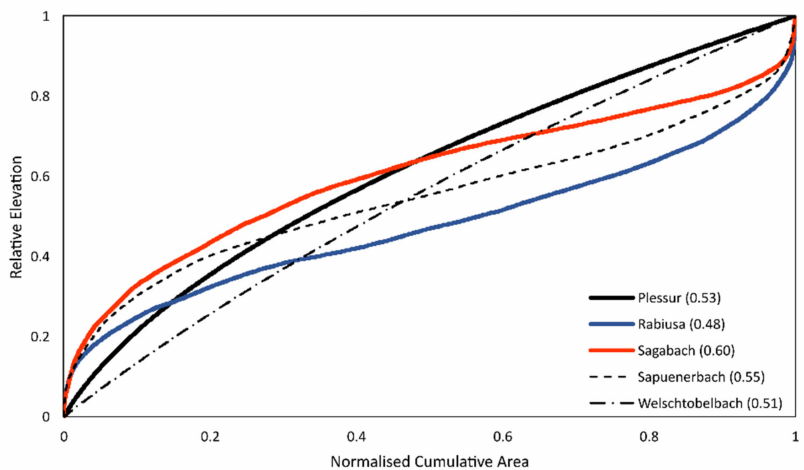
Figure 7. Comparison between the hypsographic curves of the Plessur Basin and its main tributaries. The resulting hypsometric integral (HI) is shown in the legend between